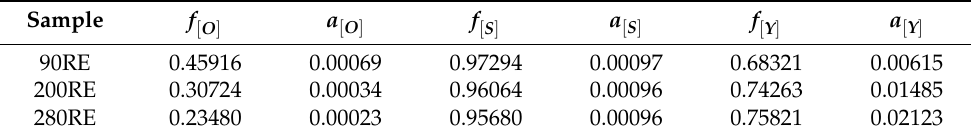
Table 3. Activity and activity coefficients of O, S and Y in the molten EH36 steels.